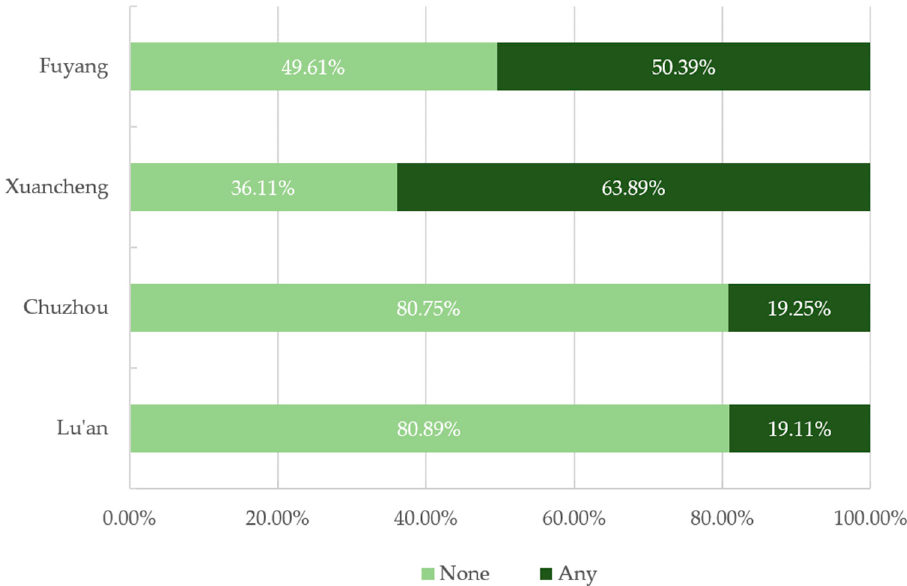
Figure 1. Proportions of people with restaurants, parks, hospitals and supermarkets within an 800 m buffer by city (%).